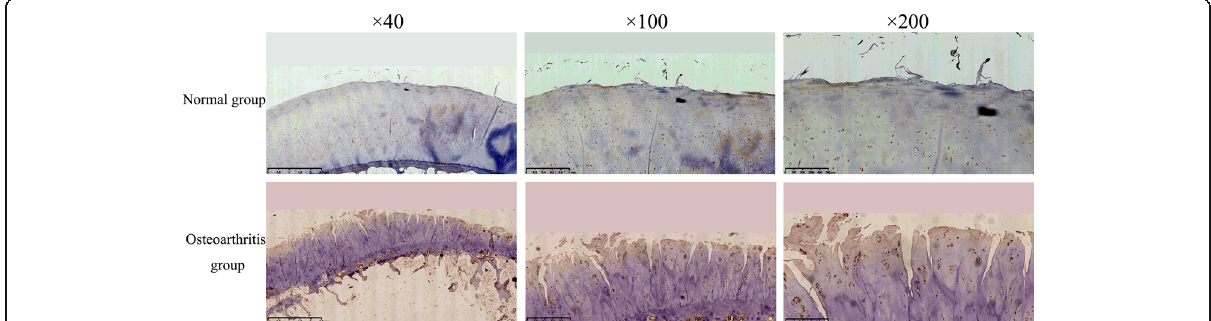
Fig. 3 The HIF-1 α staining of the cartilage in the normal group and osteoarthritis group